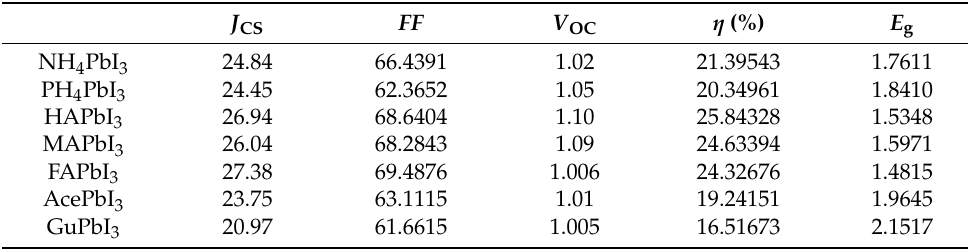
Table 3. Calculated open-circuit voltages ( V OC ), short circuit currents ( J SC ) and power conversion efficiencies ( η ) for the hypothetical perovskites A i PbI 3 and MAPbI 3 . J CS FF V OC